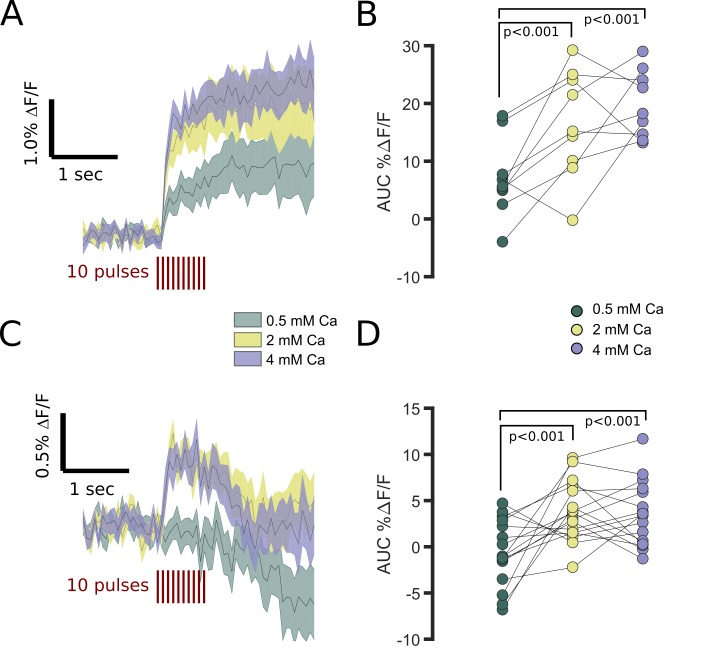
FFN102 transients are regulated by extracellular calcium.(A) Average processed transients of electrically evoked transients from striatal areas in slices perfused with 0.5, 2, and 4 mM Ca2+ (n = 9 slices). (B) There was a main effect of calcium-level on AUC %ΔF/F (repeated measures ANOVA, p < 0.001). The AUC %ΔF/F was higher in 2 and 4 mM than 0.5 mM Ca2+ (two-tailed paired t-test, p < 0.001). (C) Average processed transients of electrically evoked transients from GPe in slices perfused with 0.5, 2, and 4 mM Ca2+ (n = 16 slices). (D) The AUC %ΔF/F was higher in 2 and 4 mM than 0.5 mM Ca2+ (two-tailed paired t-test, p < 0.001). Additionally, there was a significant interaction between calcium levels and region (p<0.05).10.7554/eLife.42383.005Figure 3—source data 1.Fluorescence time courses for FFN transients evoked under varying calcium levels.10.7554/eLife.42383.006Figure 3—source code 1.Analysis and figures for FFN102 transients under varying calcium levels.